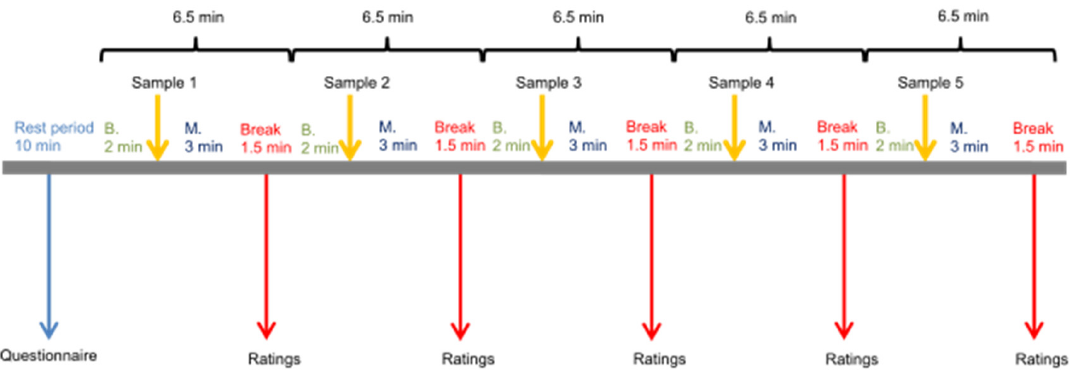
Figure 1. Schematic representation of the psychophysiological test regimen.